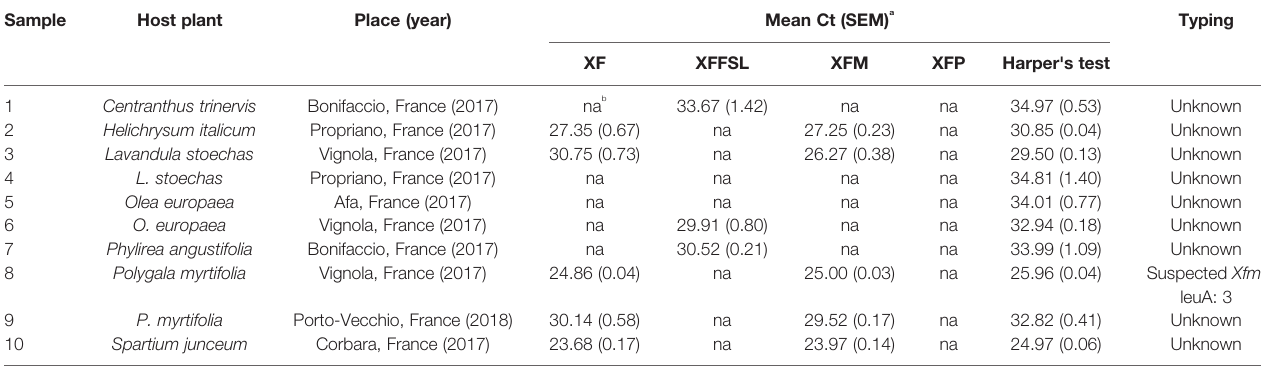
TABLE 6 | Detection of X. fastidiosa in environmental plant samples with low population sizes using the tetraplex qPCR assay set n°1 in comparison with the reference test (Harper's test, Harper et al., 2010).